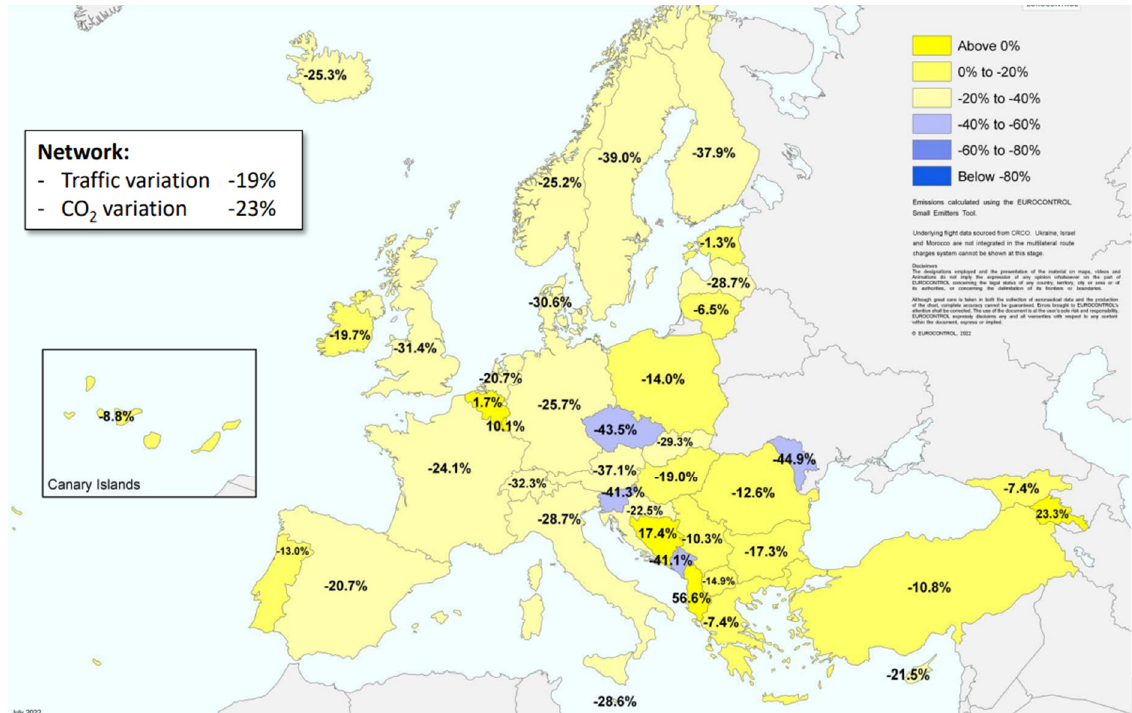
Figure 7. CO 2 variation from January to June 2022 vs. 2019 departures. Source Reprinted with permission from EUROCONTROL [39].